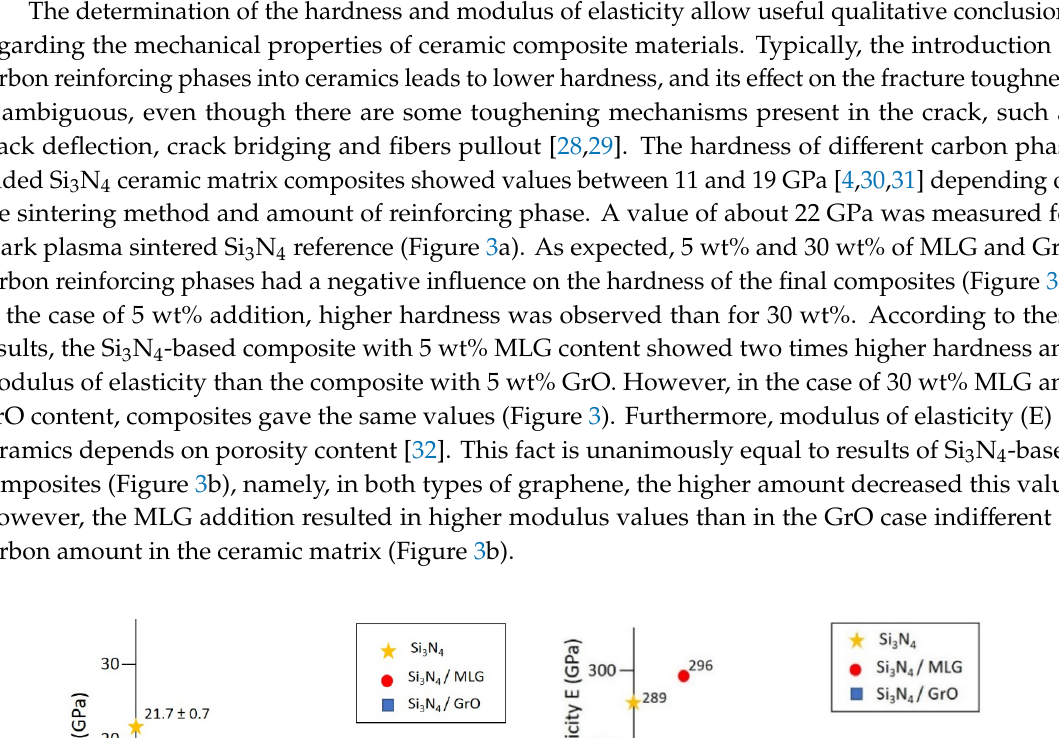
( b ) Figure 4. Fracture behavior of Si 3 N 4 -based composites. ( a ) fracture toughness, ( b ) 3 -point bending strength. K IFR = 0.0334(E/H) 0.4 (P/l 1.5 ), where H is the Vickers hardness, E is the modulus of elasticity, P is the applied force and l is the length of cracks. On the other hand, GrO addition due to different structure had more negative effect on strength and toughness of composites for both contents (Figure 4b). According to the results above, it could be seen that the more porous layer with higher graphene content under a tensile stress was, the main factor for fracture during the three-point bending test. 3.2. Structural Properties of Spark Plasma Sintered Si 3 N 4 -Based Composites The density values were the lowest for the reference Si 3 N 4 ceramic, while the highest values were obtained in the cases of 5% MLG and GO reinforcing phases (Figure 5). The density values decreased with increasing carbon phase content, approaching the value of reference ceramic. The lower density